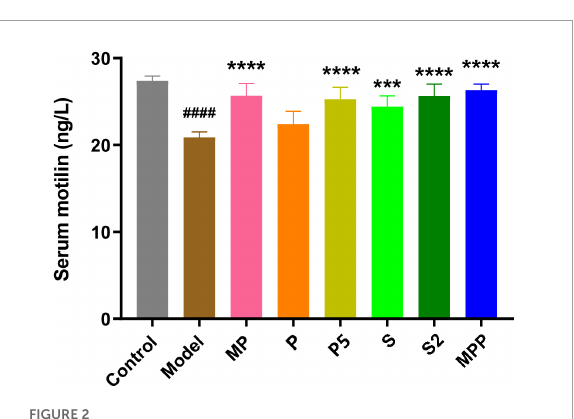
FIGURE2 The differences in serum motilin level among groups. Values are expressed as mean ± SEM ( n = 8). Results were compared by one-way ANOVA and Dunnett’s multiple comparison test: *** p < 0.001, **** p < 0.0001 compared with the model group; #### p < 0.0001 compared with the control